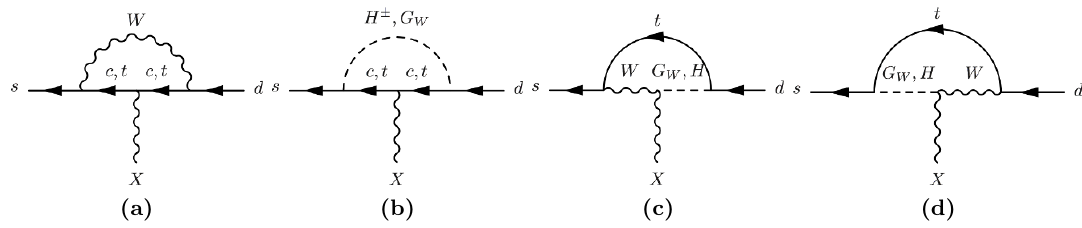
Figure 3. Feynman diagrams involved in the calculation of K + ! (cid:25) + X . Analogous diagrams were computed for B + ! K + X